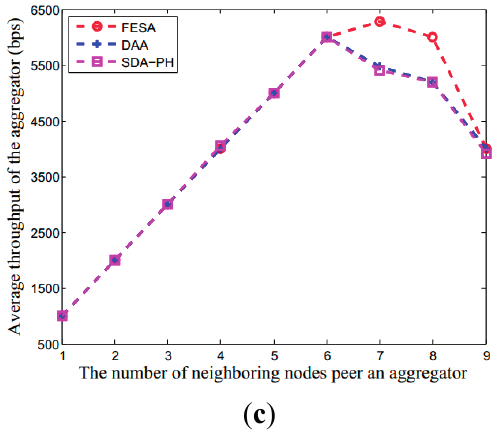
Figure 5. The performance in aggregator under DAA, SDA-PH and our scheme. Although it is more complex using FHE, the performance of our scheme is also better than other